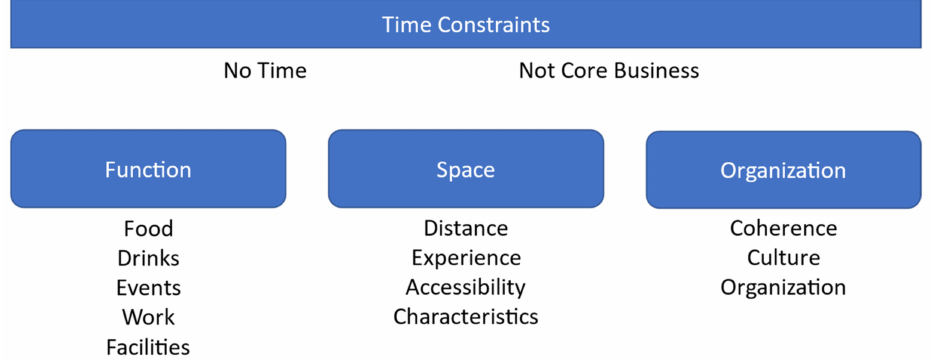
Figure 4. Thematic